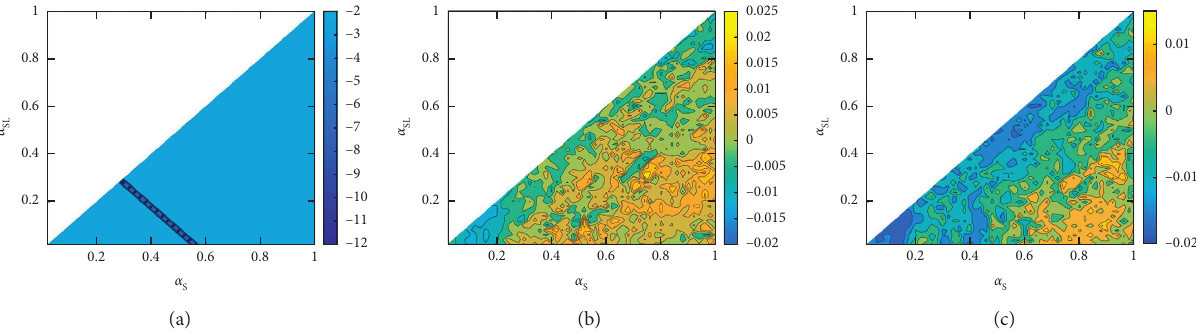
Figure 12: LLE diagram of supply chain nodes under the scenario of random demand obeying uniform distribution from the global � 5. (a) The retailer’s LLE chart. (b) The LLE chart of the distribution center. (c) The LLE chart of the perspective when G d � 2 and G 2 combined system from the decision perspective.